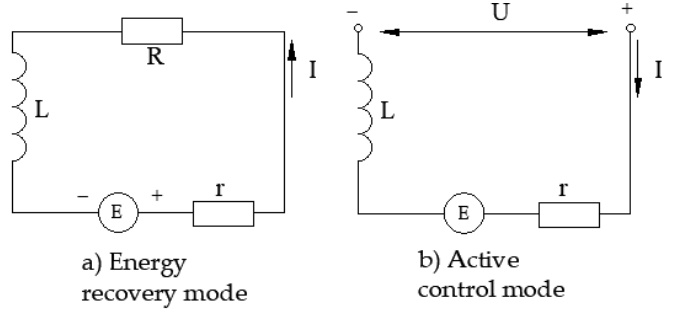
Figure 6. Equivalent circuit diagram of the energy regenerative motor.